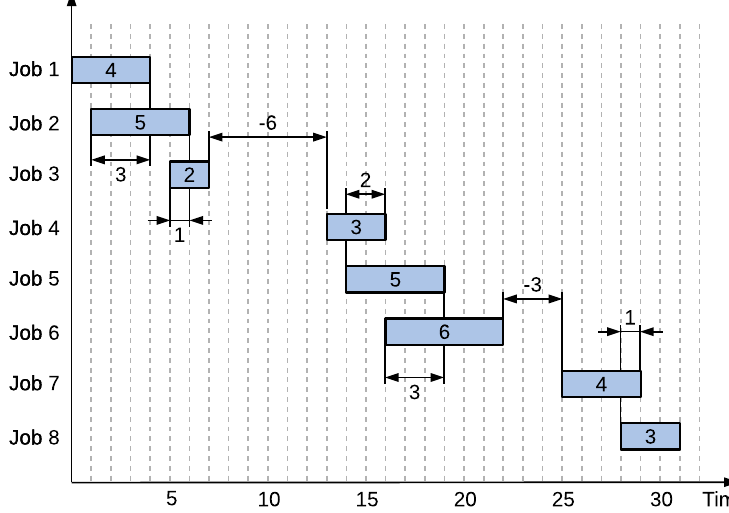
Figure 2. Exemplary schedule on a machine with some overlapping jobs. The required “local” job starting times shifts are